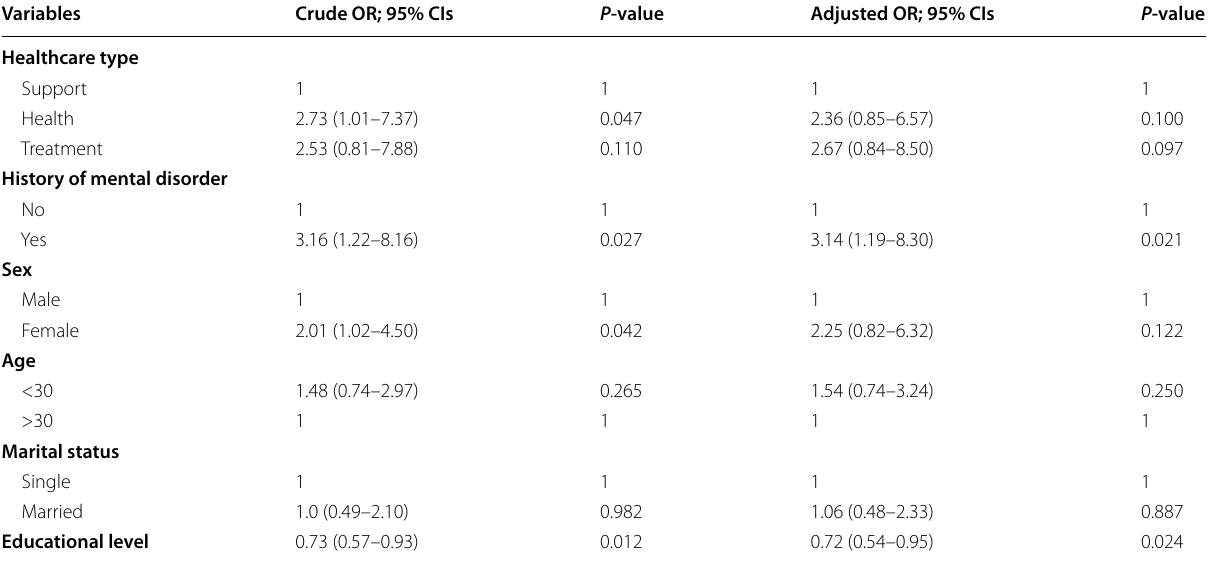
Table 4 Association between MDD and health service provider type during the COVID-19 pandemic by multiple logistic regression analysis after adjusting for the potential